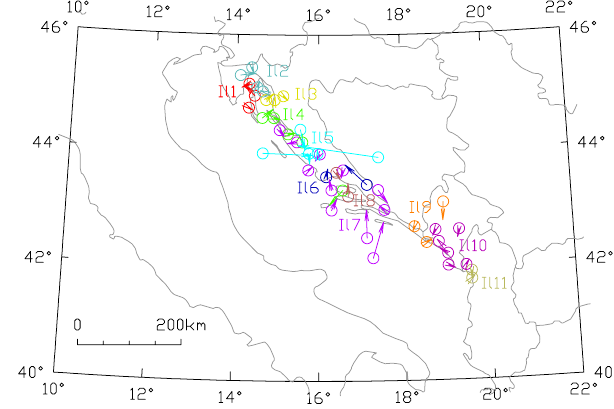
Figure 5. Illyricum : residual plot after the determination of trans- formation units ( point : (¯ λ, ¯ φ ), arrowhead : ( λ,φ )).